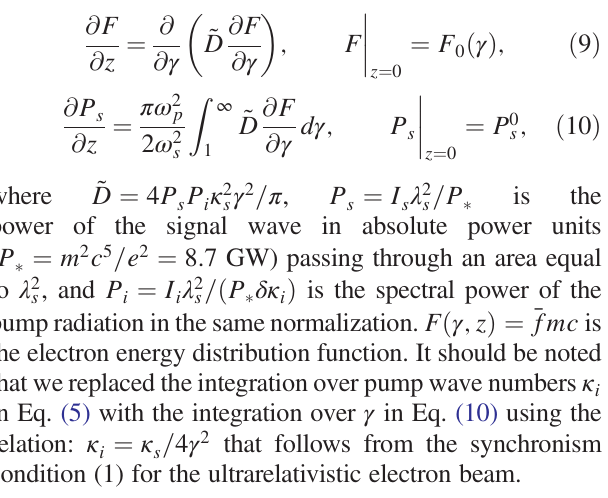
FIG. 2. Single-pass amplifier. (a) Mutual arrangement of ⌢ ð u Þ with initial energy dispersion electron distribution function F δ ¼ 0 . 035 and profile of pump spectrum (blue line) with a half- width σ ¼ 0 . 07 in the energy space. The shift between the center of the pump spectrum and the center of the electron distribution ¼ 0 . 05 . (b) Dependence of spatial growth function is ε ¼ 1 − u i rate Λ on relative shift ε for different values of the pump spectrum half-width σ calculated for electron energy dispersion δ ¼ 0 . 035